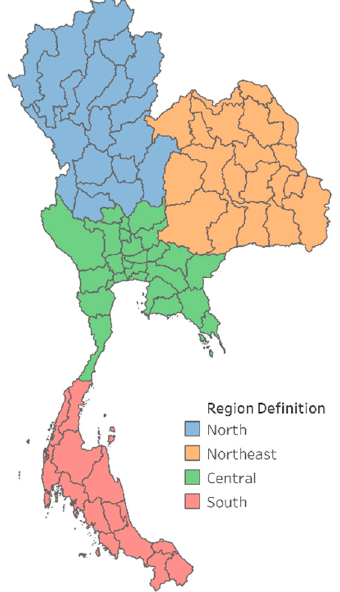
Figure 3. Definition of geographical regions in Thailand.